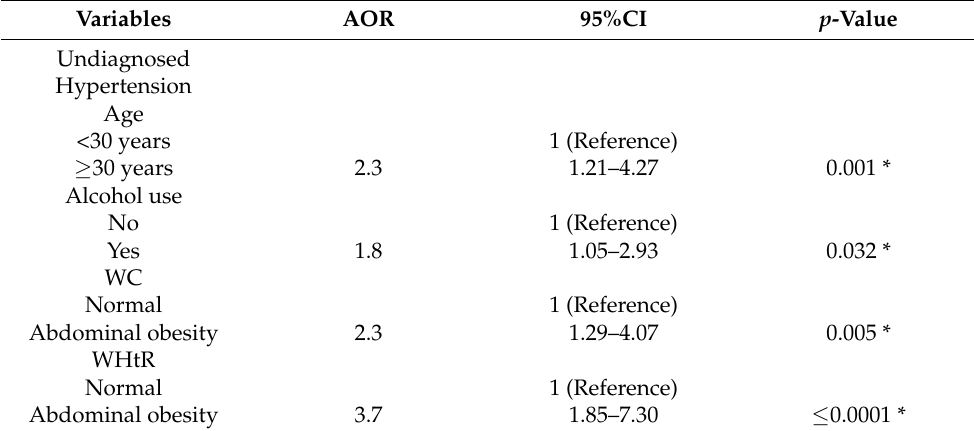
Table 5. Association of undiagnosed hypertension with